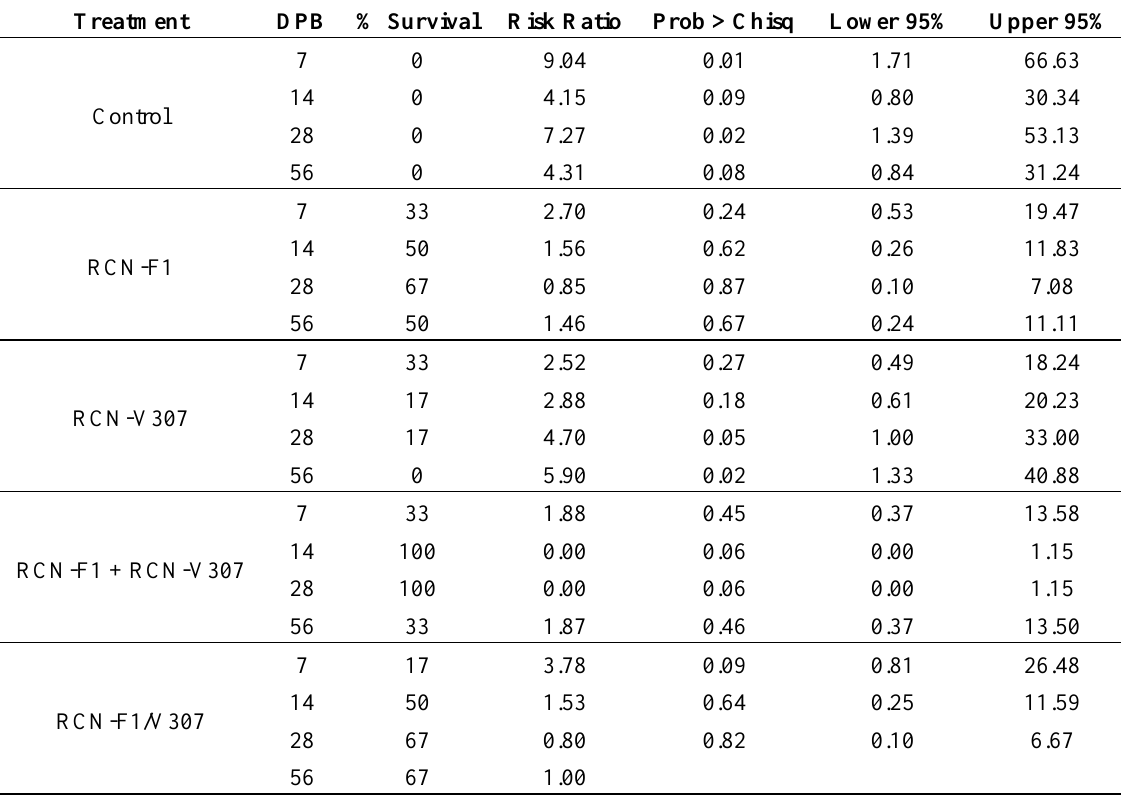
Table 1. Vaccine treatments administered to A/J mice via intramuscular inoculation and their response to challenge with Yersinia pestis (CO92) at various days post booster vaccination (dpb) at a dosage of 1.4 × 10 4 mouse LD 50 s. Risk ratios are calculated in relation to RCN-F1/V307 at day 56 dpb. Lower and upper 95% indicate 95% confidence intervals on the risk ratio.